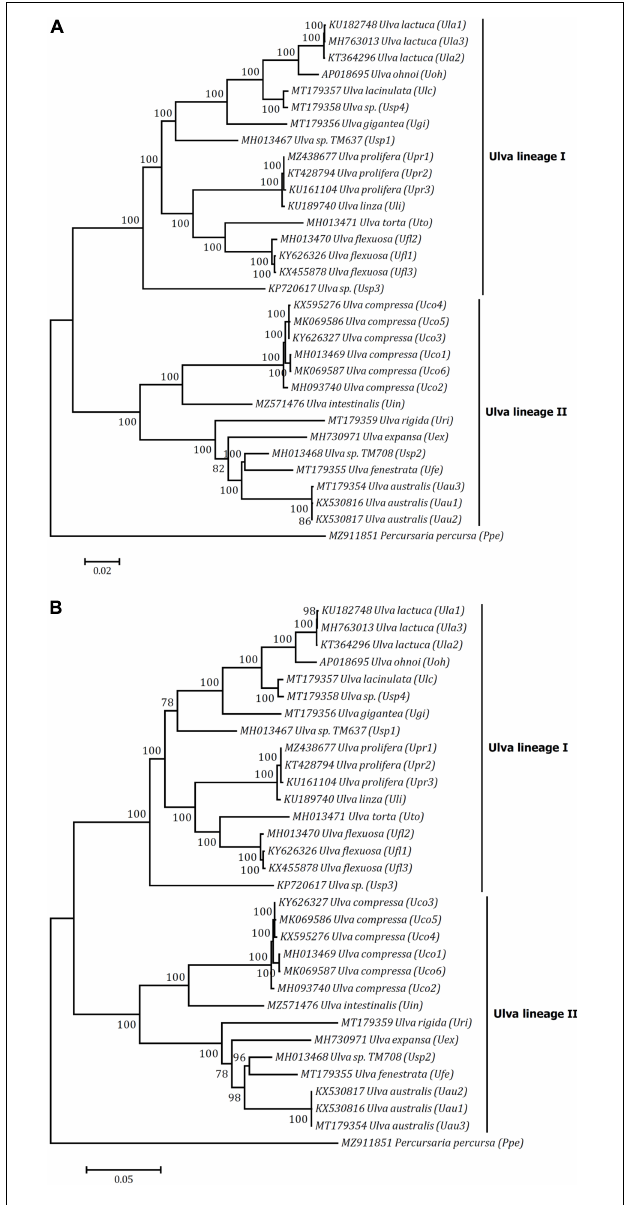
FIGURE 7 | Phylogenomic trees based on Maximum Likelihood (ML) analysis of the nucleotide (nt) sequences of 61 genes (A) and the amino acid (aa) sequences of 32 genes (B) in 32 ulvalean mitogenomes. The mitogenome of Ulva meridionalis ( Ume ) was not included due to its incomplete cox1 gene. The ML analysis was conducted with 1,000 bootstrap replicates using MEGA 7.0. The bootstrap support values greater than 70% were displayed at branches. Branch lengths were proportional to the amount of sequence change, which were indicated by the scale bar below the trees. The tree was rooted with Percursaria percursa ( Ppe ) as an